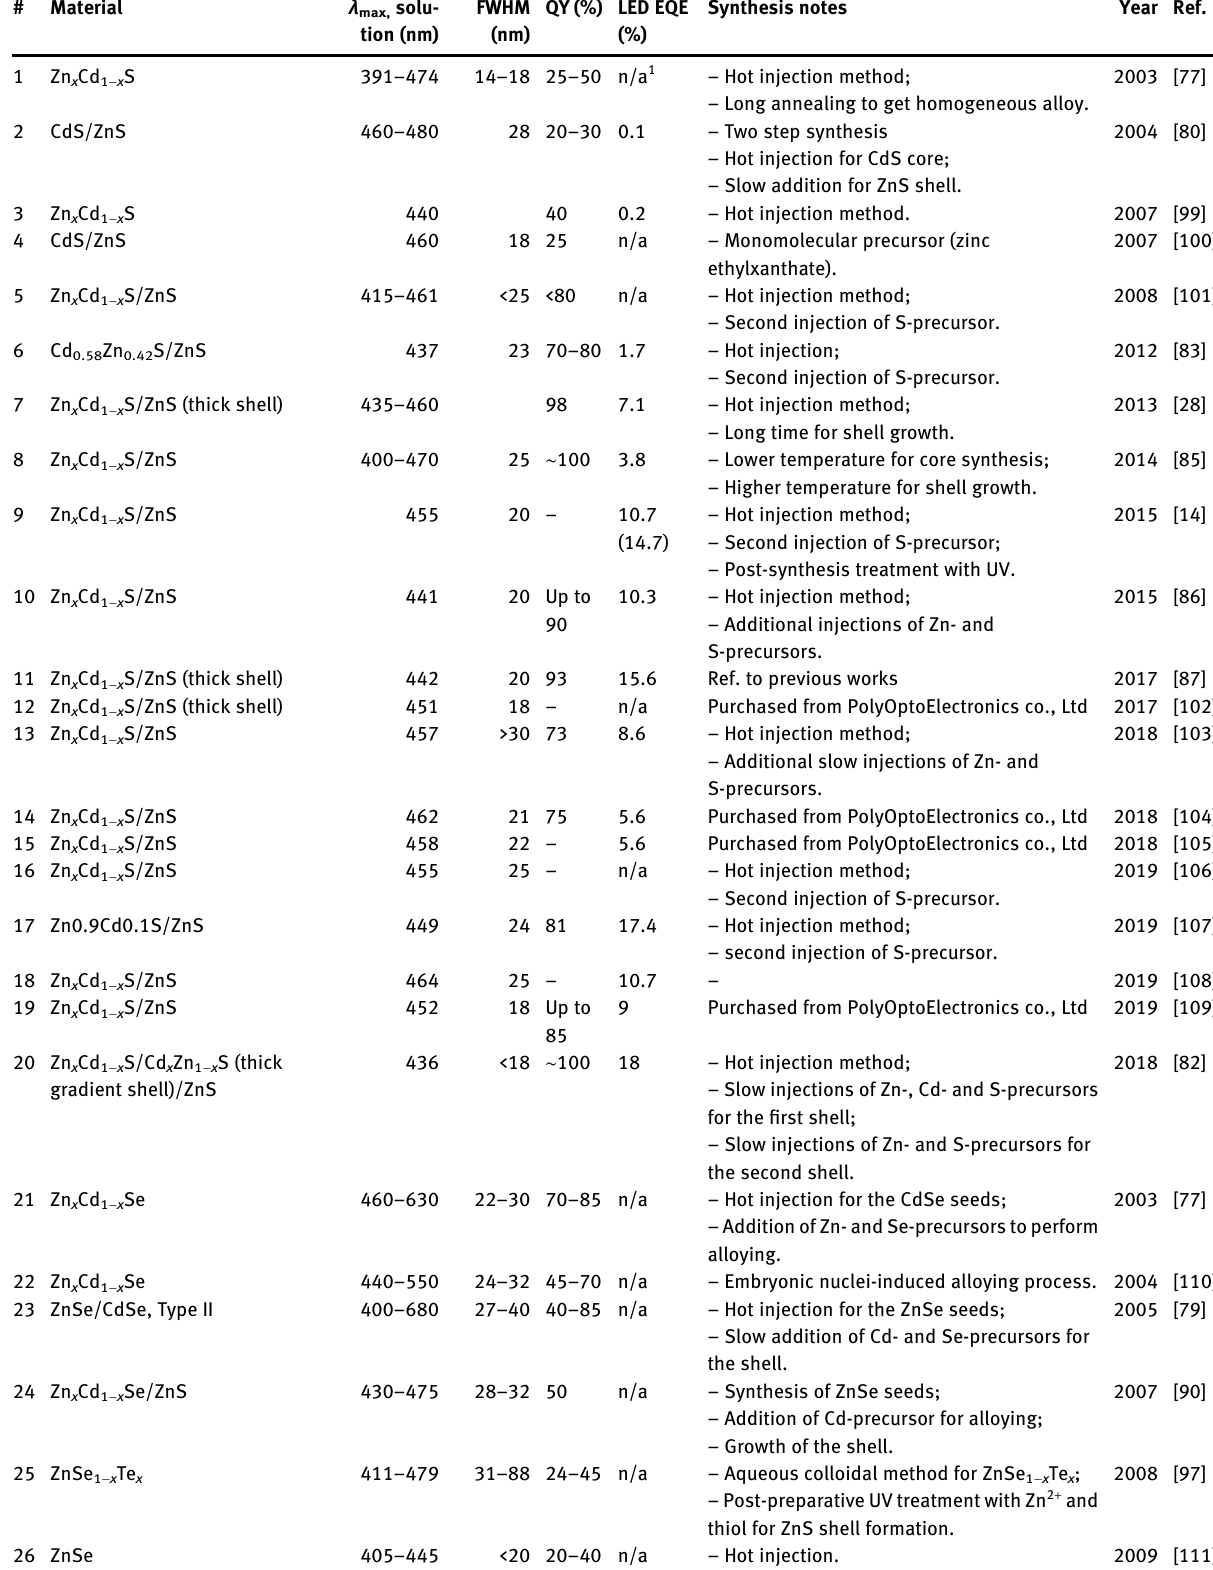
Table  : A II B VI blue emitting luminescent nanoparticles, their PL/EL and synthesized